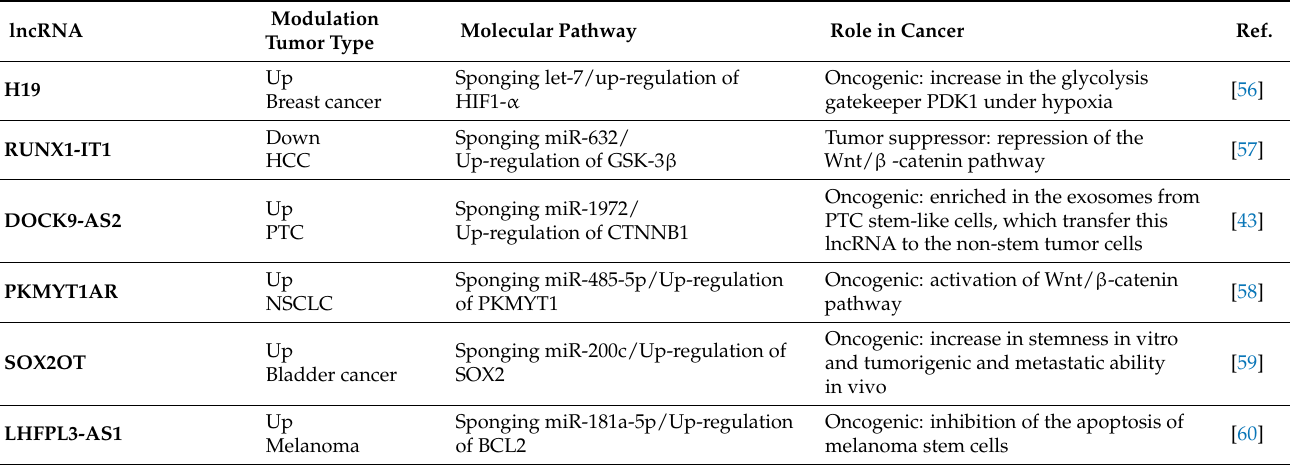
Table 2. LncRNAs working in the cytoplasm as competing endogenous RNAs and through the interaction with